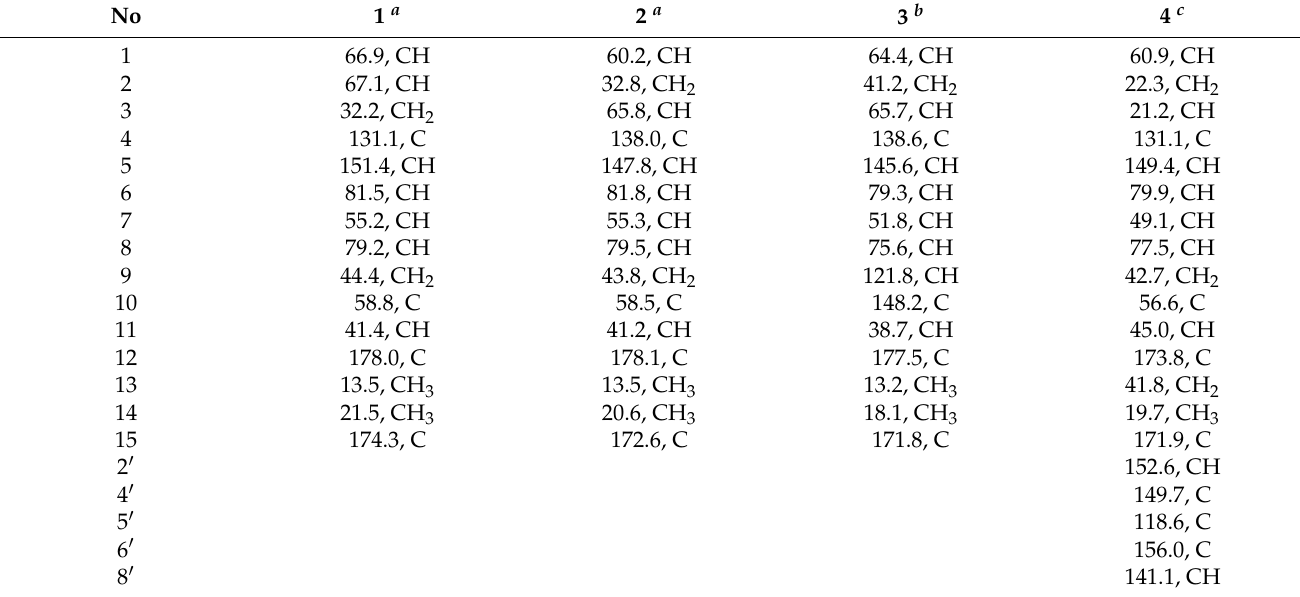
Table 2. 13 C NMR data of compounds 1 – 4 , δ in